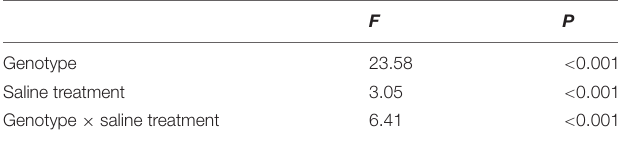
TABLE 3 | Two-way ANOVA examining the effects of genotype, saline treatment and their interaction (genotype × saline treatment) on the V J of leaves from the three P. amurensis sample